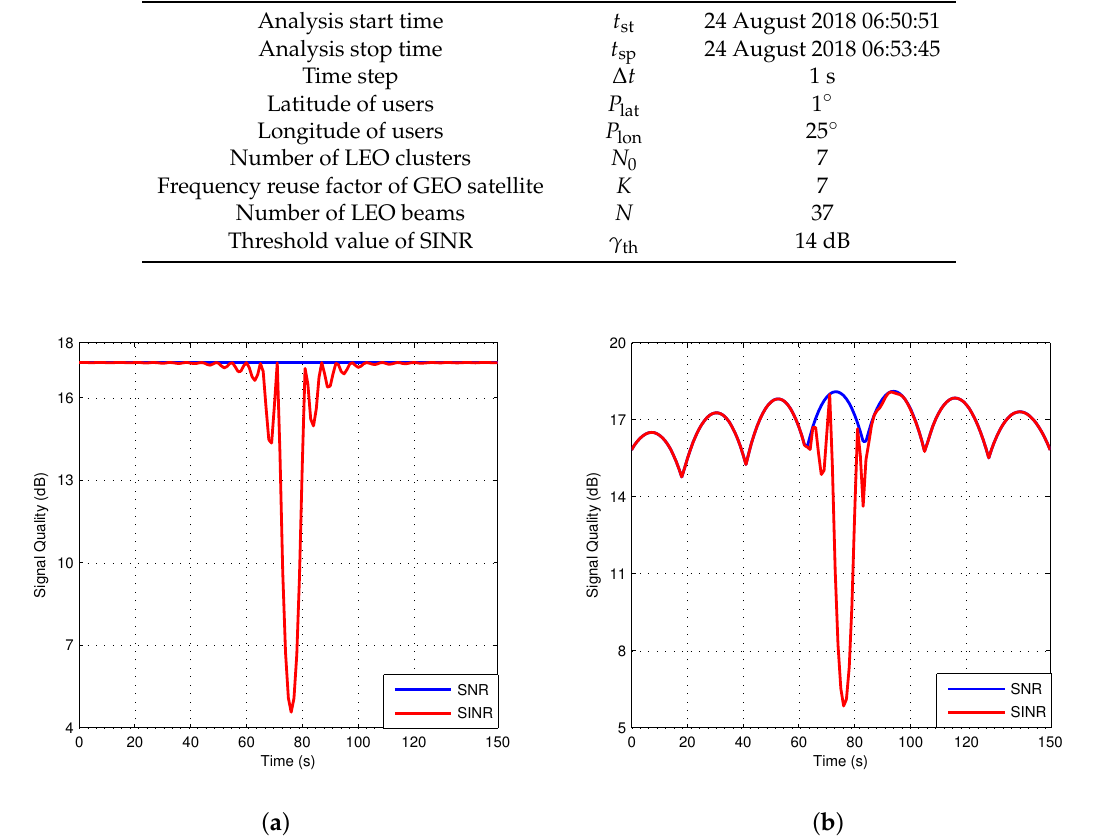
Figure 7. Comparison of signal quality with and without interference. ( a ) GEO user; ( b ) LEO